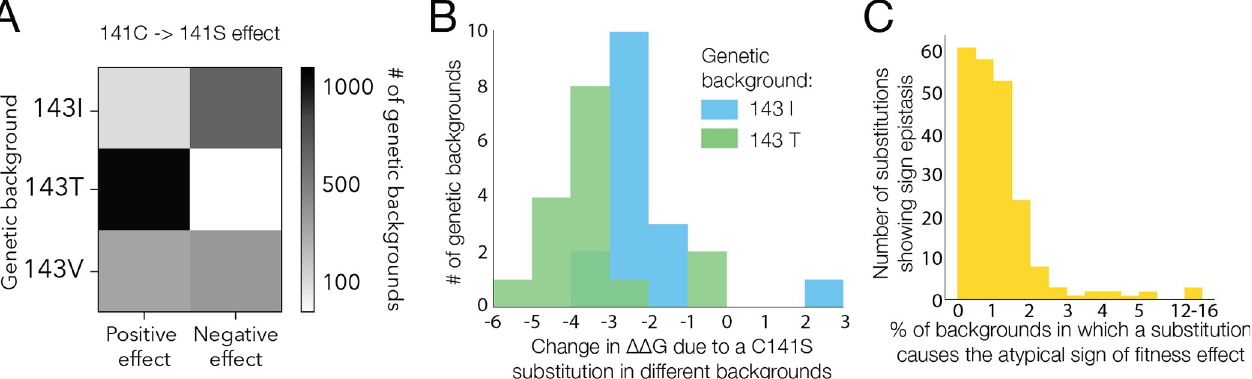
Fig 6. Sign epistasis. a, Amino acid replacement C- > S at site 141 in segment 2 more frequently has a positive effect on fitness in the background of T at site 143, a negative effect in the background of 143I and is equally likely to be strongly deleterious or strongly beneficial in the background of 143V. b, Predicted change in folding free energy using Rosetta [64] following a C141S replacement in all genetic backgrounds with an I or T at 143 and that are closer than four mutations away from S. cerevisiae . c, the fraction of genotypes in which the amino acid replacement under sign epistasis has the less frequent effect on fitness. https://doi.org/10.1371/journal.pgen.1008079.g006 2